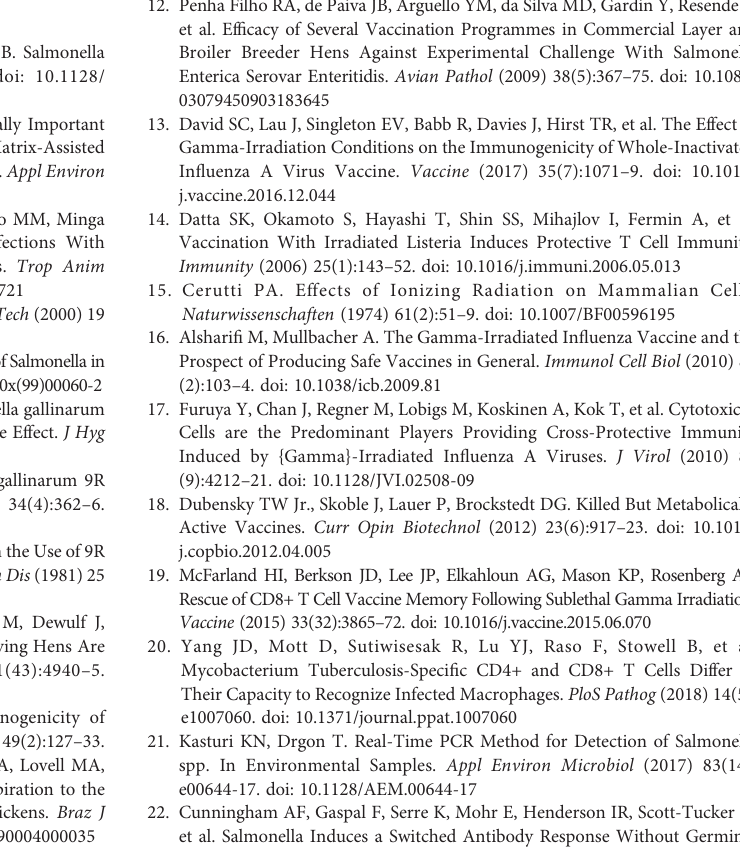
Supplementary Figure 1 | Measurement of Serogroup B or D speci fi c LPS antibody responses induced by r-SG. Mice (n = 5 per group) were immunized i.p. with 1 × 10 6 CFU of r-SG or f-SG three times at two week intervals and sera were collected two weeks after the last vaccination. (A, B) Serogroup B or DLPS speci fi c antibody levels were measured by ELISA. Serogroup B and D-speci fi c IgM (A) and Serogroup B and D-speci fi c IgG (B) . *P < 0.05, **P < 0.01, ***P < 0.001, compared to unvaccinated mice or f-SG vaccinated